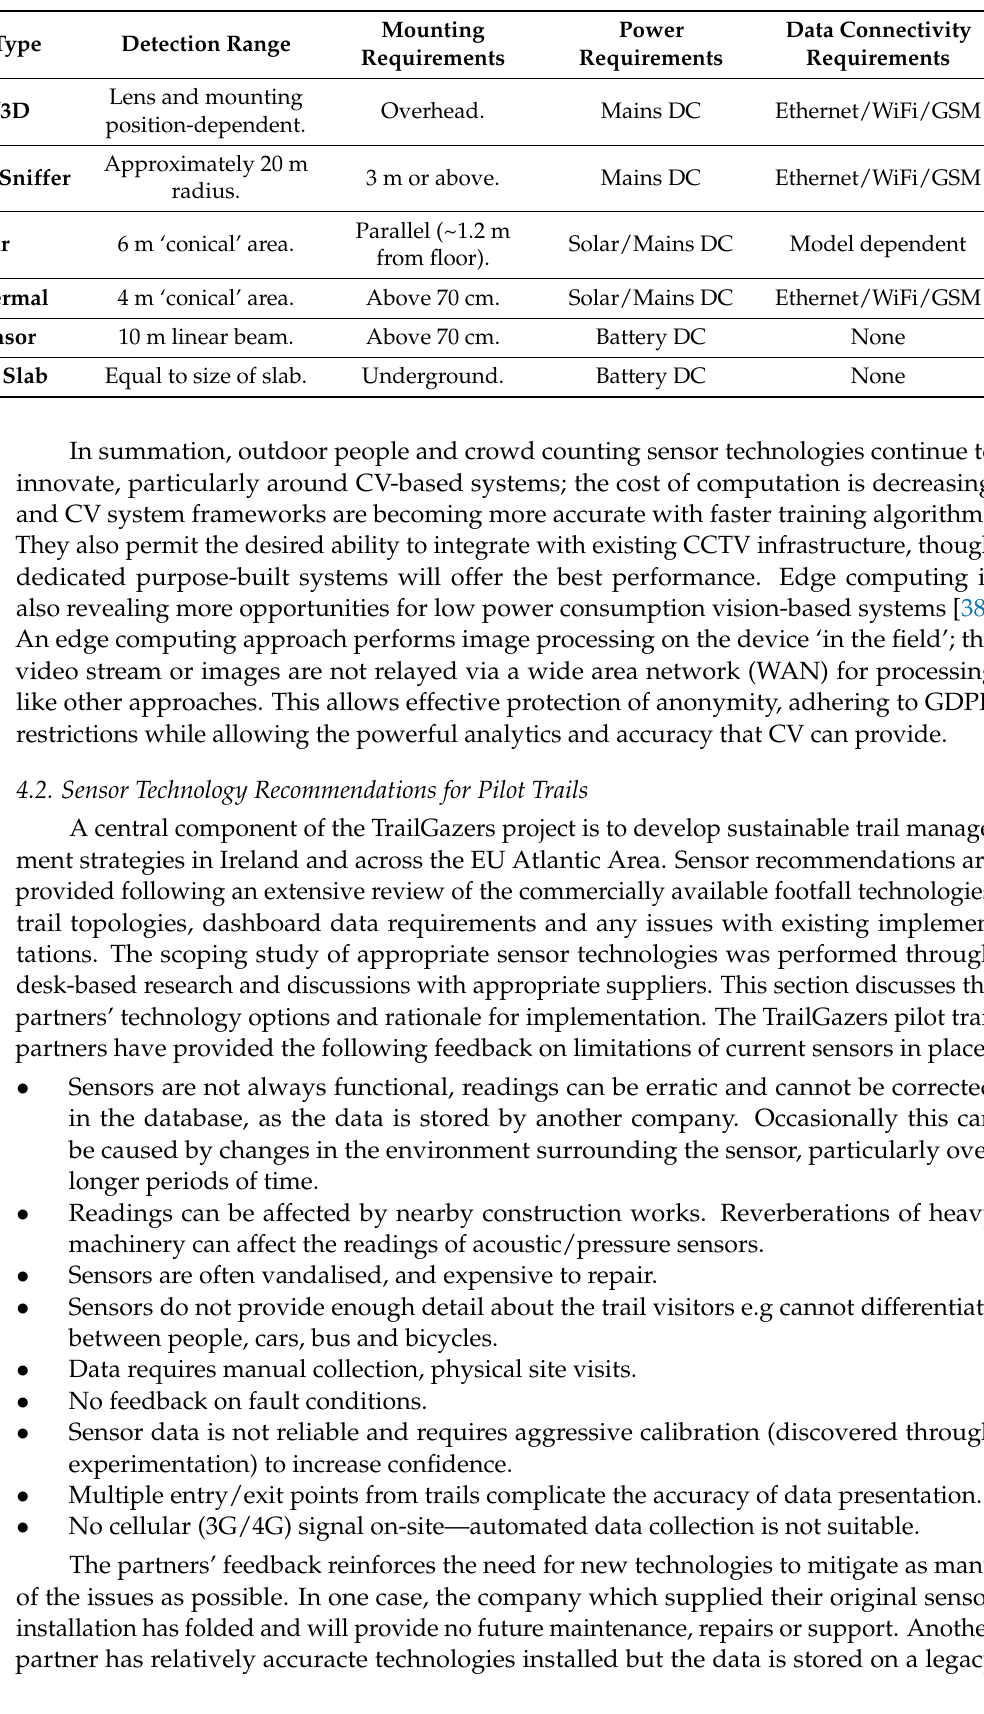
Table 1. Sensor Overview and